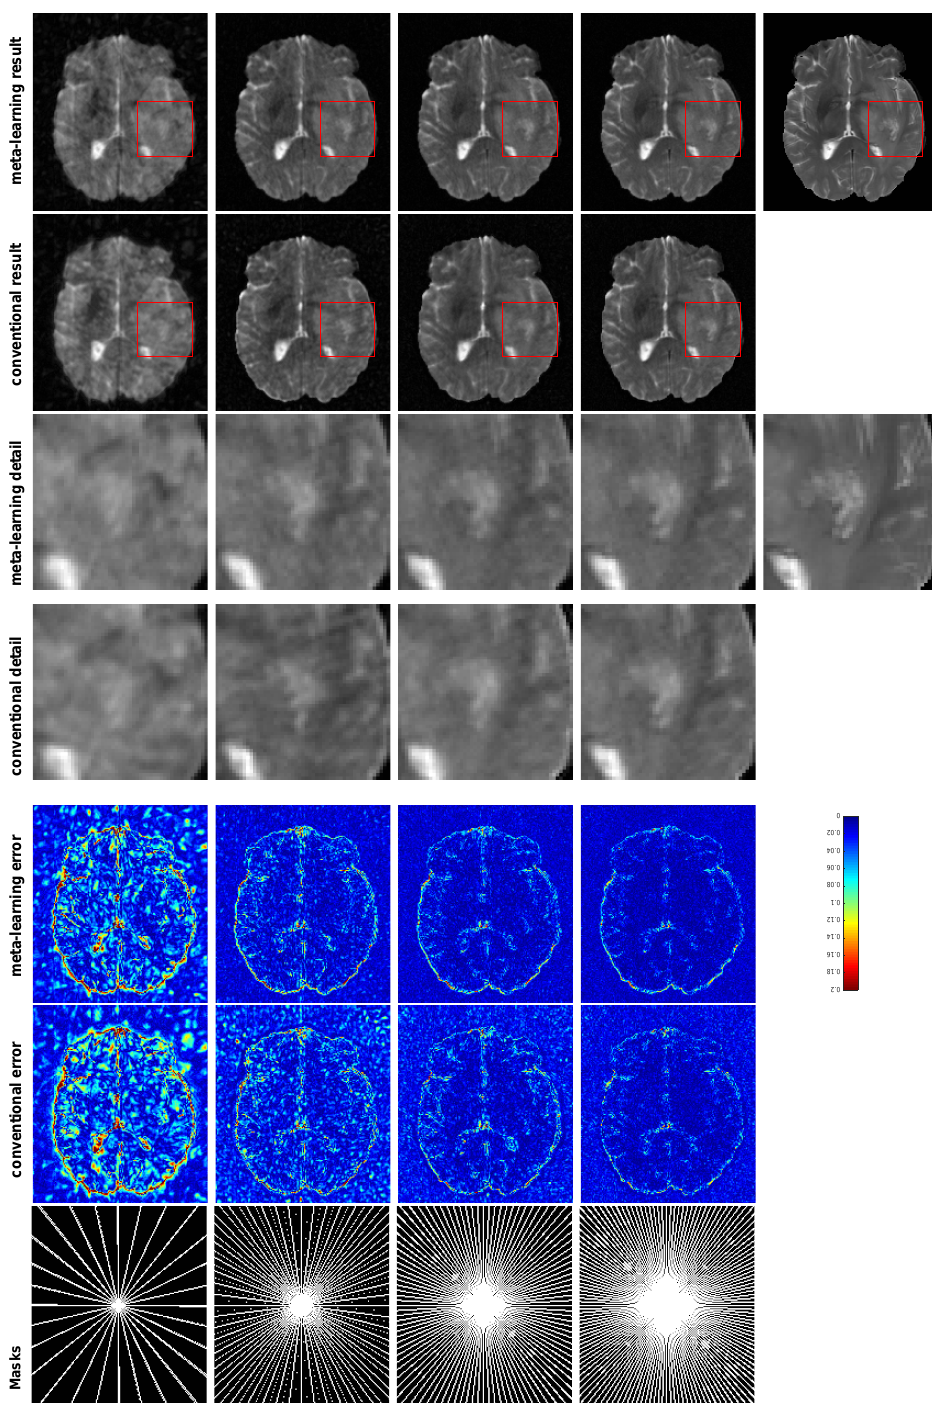
Figure 2. The pictures (from top to bottom) display the T2 brain image reconstruction results, zoomed-in details, point-wise errors with a color bar, and associated radial masks for meta-learning and conventional learningwith four different CS ratios of 10%, 20%, 30%, 40% (from left to right). The top-right iage is the ground truth fully-sampled